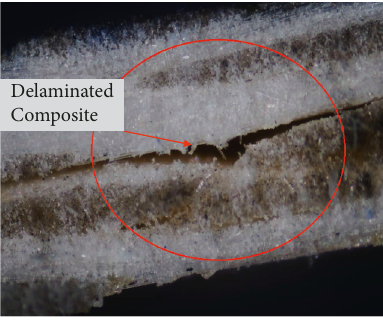
Figure 11: Microscopic image of the delaminated sample showing crack after impact test.